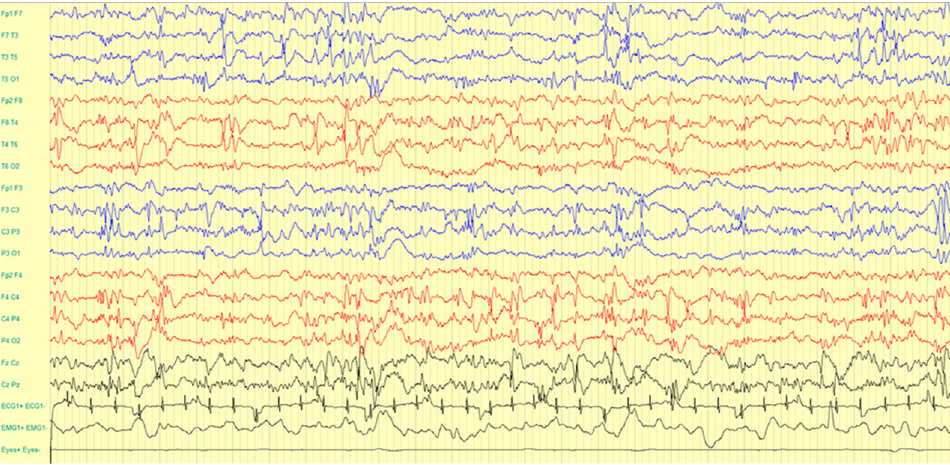
Figure 1. EEG during NREM sleep showing frequent and independent epileptiform abnormalities over bilateral frontotemporal regions.